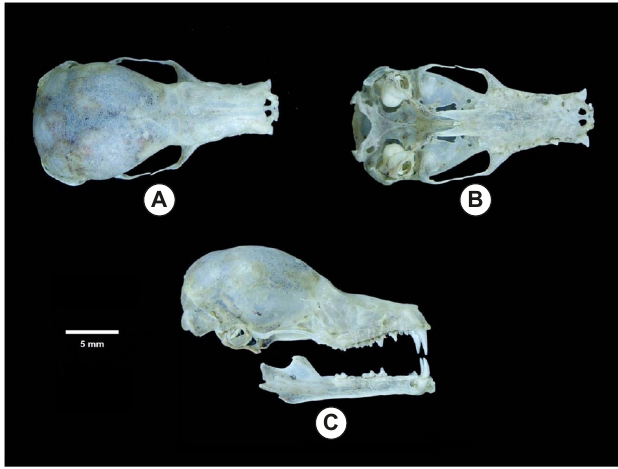
Anoura fistulata Skull of a male specimen (MUSA 9925) collected in Ollachea, Carabaya, Puno,